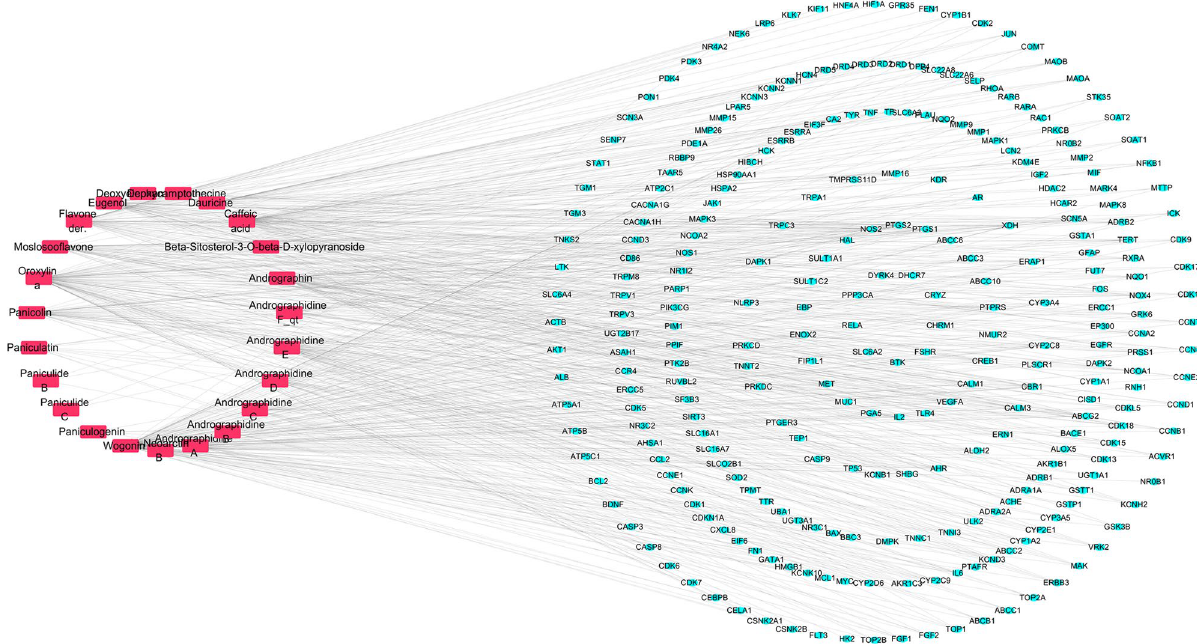
Figure 1. Compound-Target network. The red square nodes represent the bioactive compounds, and the blue oval nodes represent the predicted